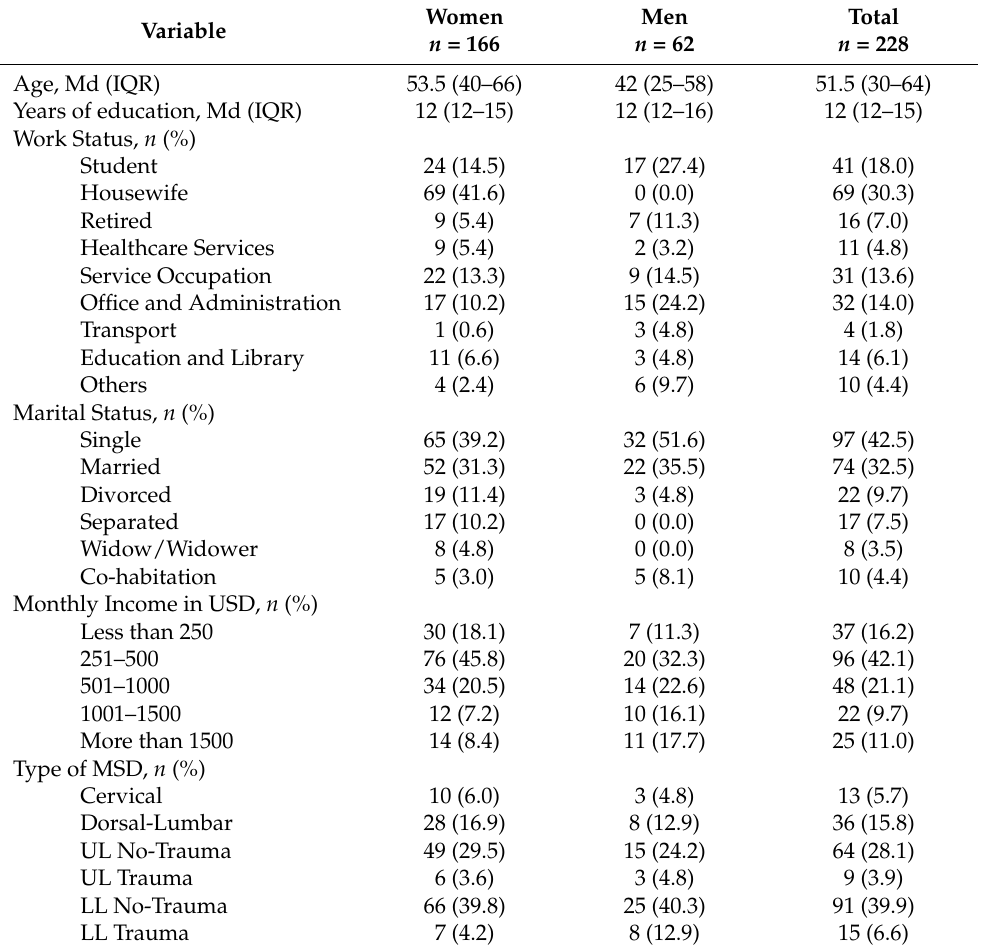
Table 1. Sociodemographic characteristics by